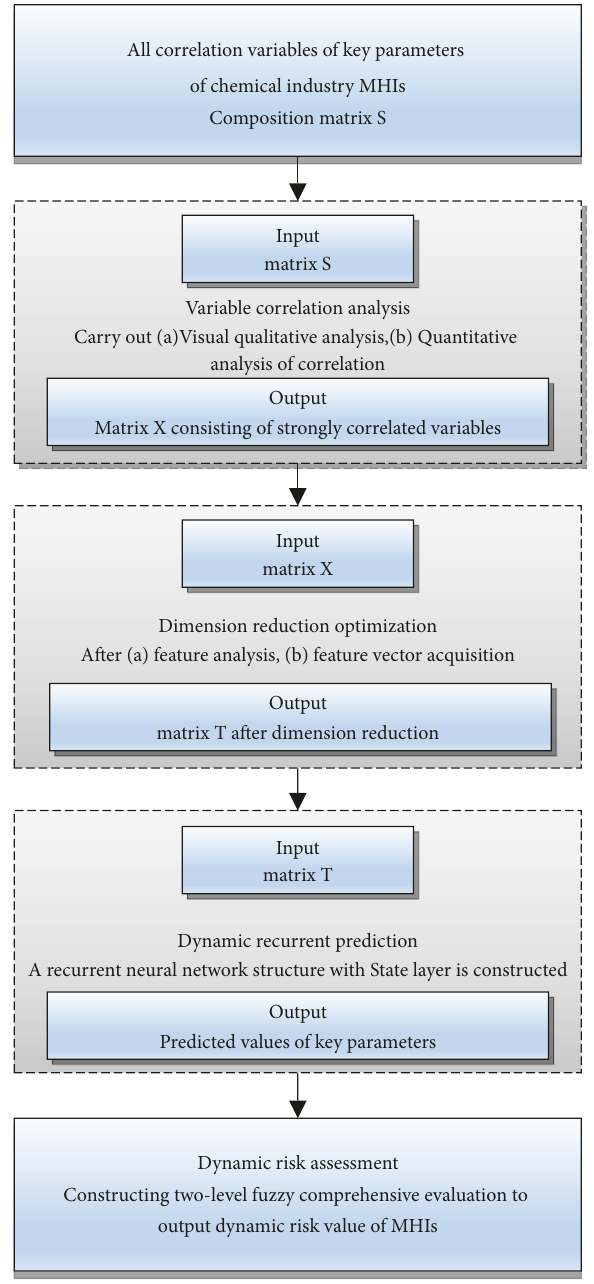
Figure 1: Structure block diagram of dynamic early warning